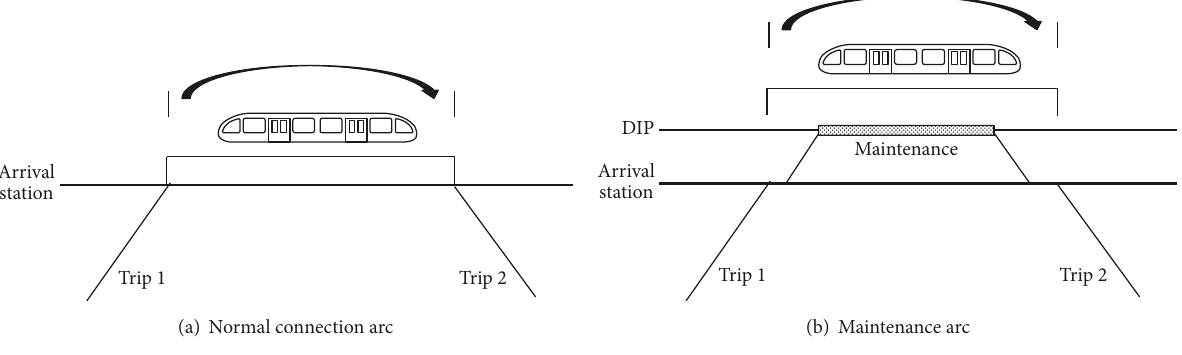
Figure 6: Two different